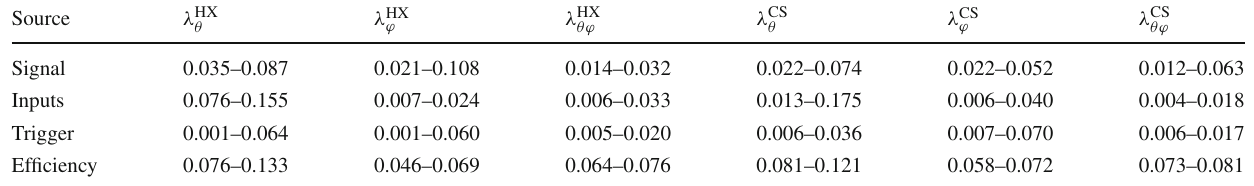
the MC simulations (inputs), the low- p T trigger response (trigger) and the detector efficiency (efficiency). The last three sources enter in the computation of the acceptance and efficiency factor ( A × (cid:10)